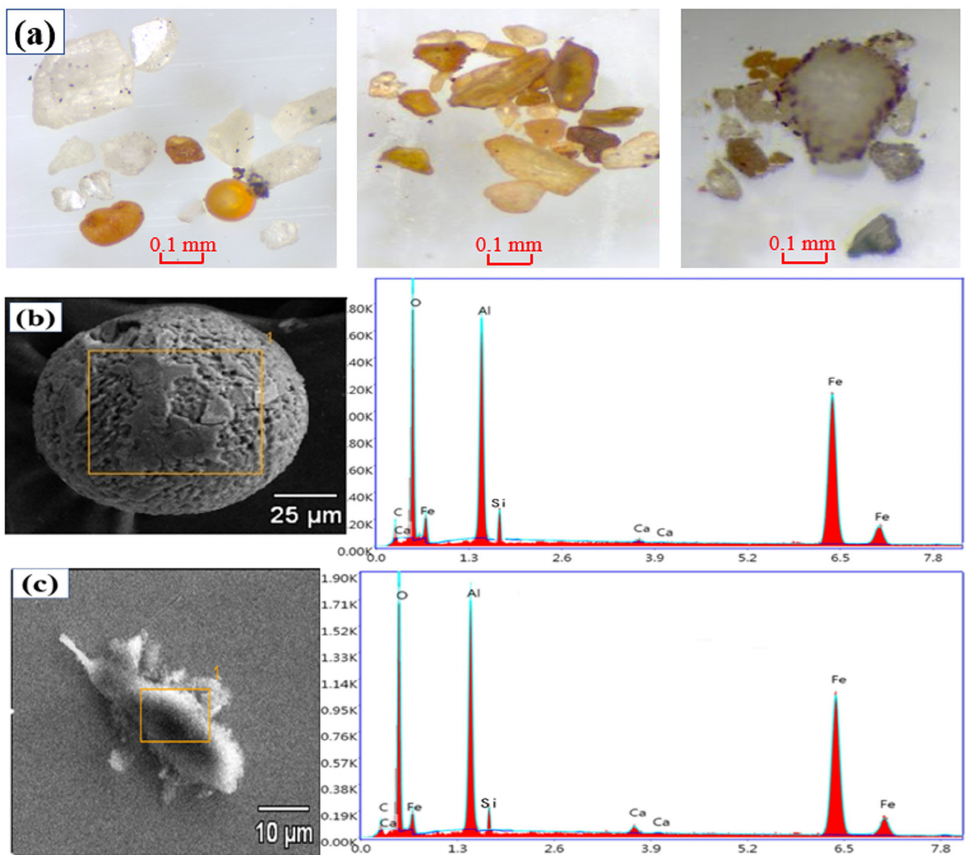
Figure 8. Scanning electron microscopy-energy disperse spectroscopy of inclusions; (a) Morphology of inclusions;(b) Spherical morphologies